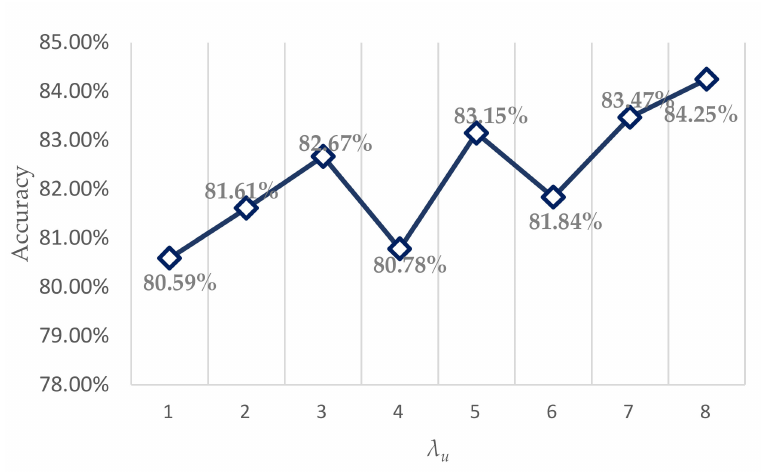
Figure 9. Model accuracy with different λ u